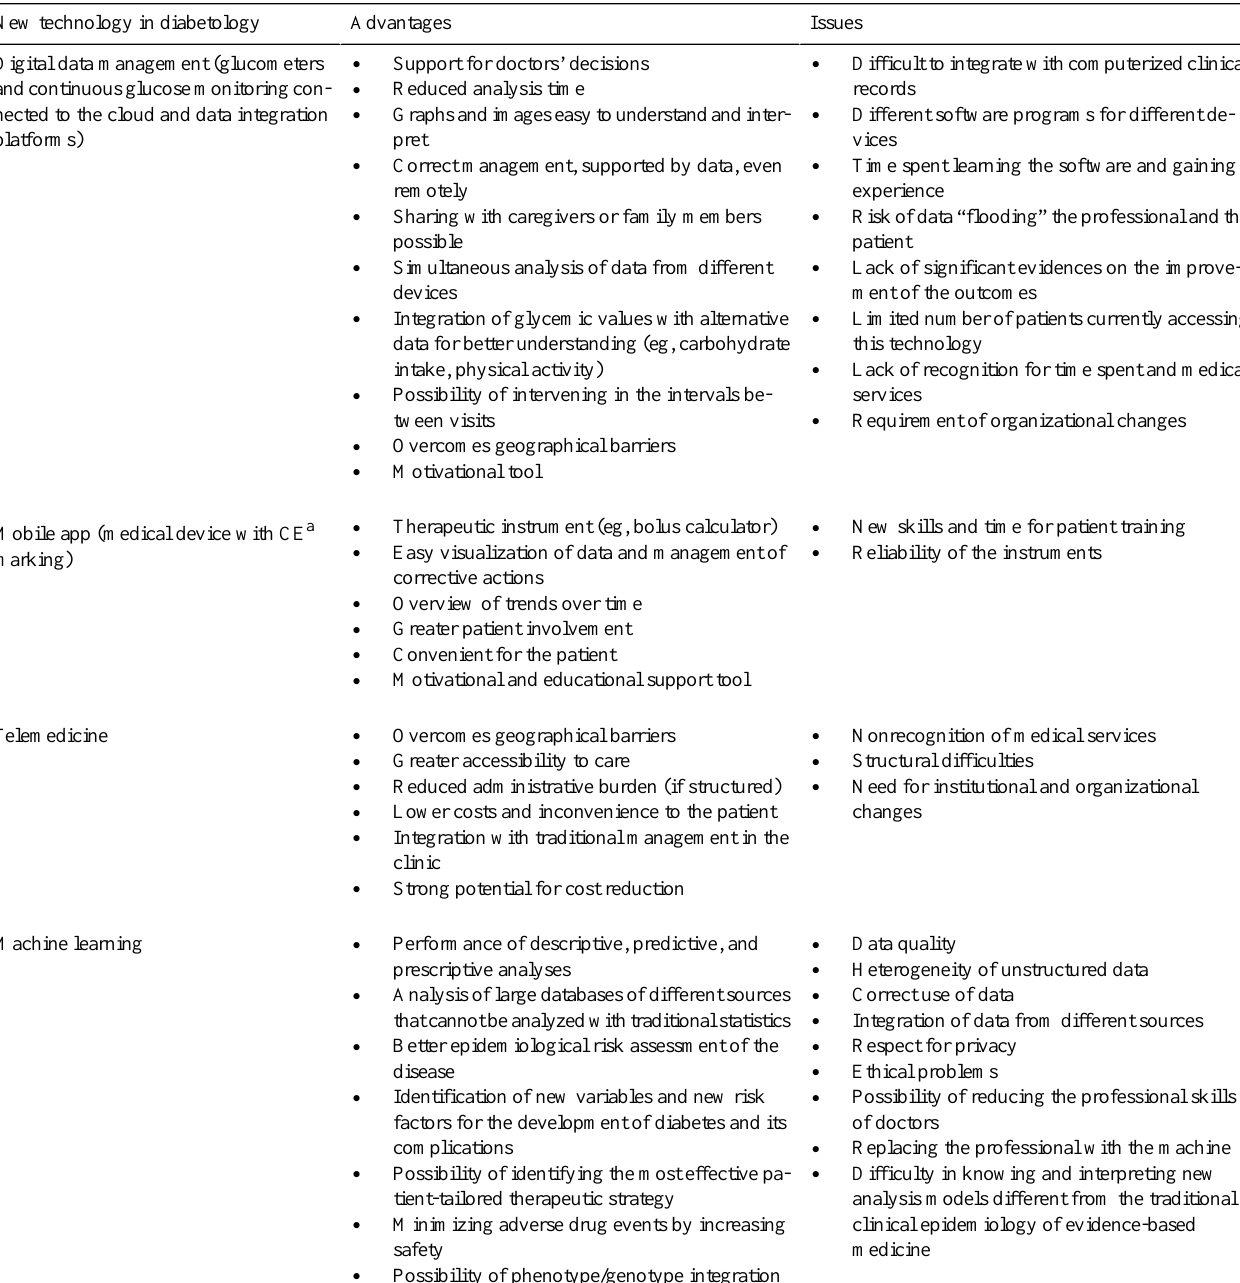
Table 1. Advantages and weaknesses of the use of new technologies in diabetology (our